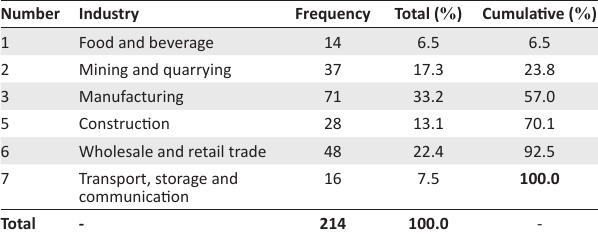
TABLE 1: Sample companies classified by